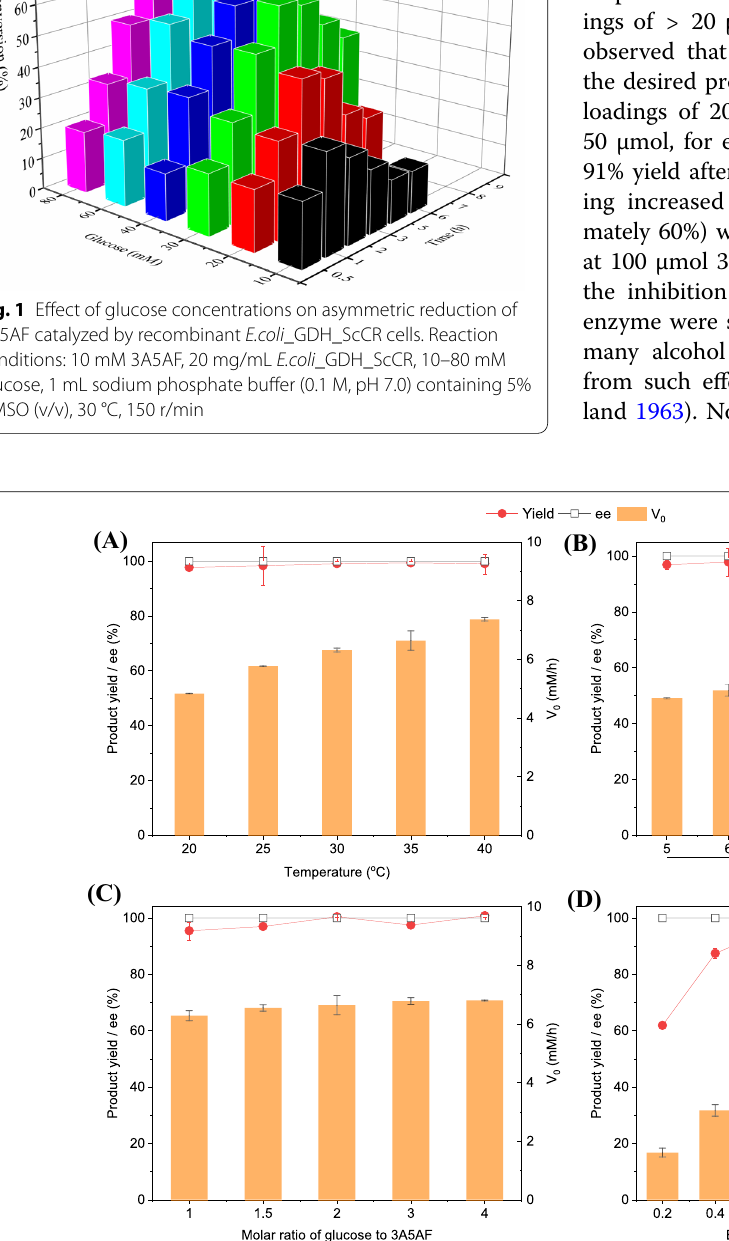
2:1, 0.1 mM NADH, 1 mL sodium =